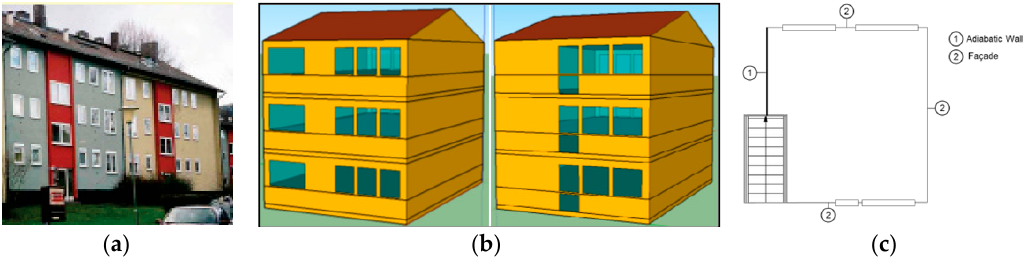
Figure 1. ( a ) Multi-family house constructed between 1958–1968 [18]; ( b ) Front side ( left ) and backside ( right ) of the building model used in simulations; ( c ) Home plan. ( right ) of the building model used in simulations; ( c ) Home